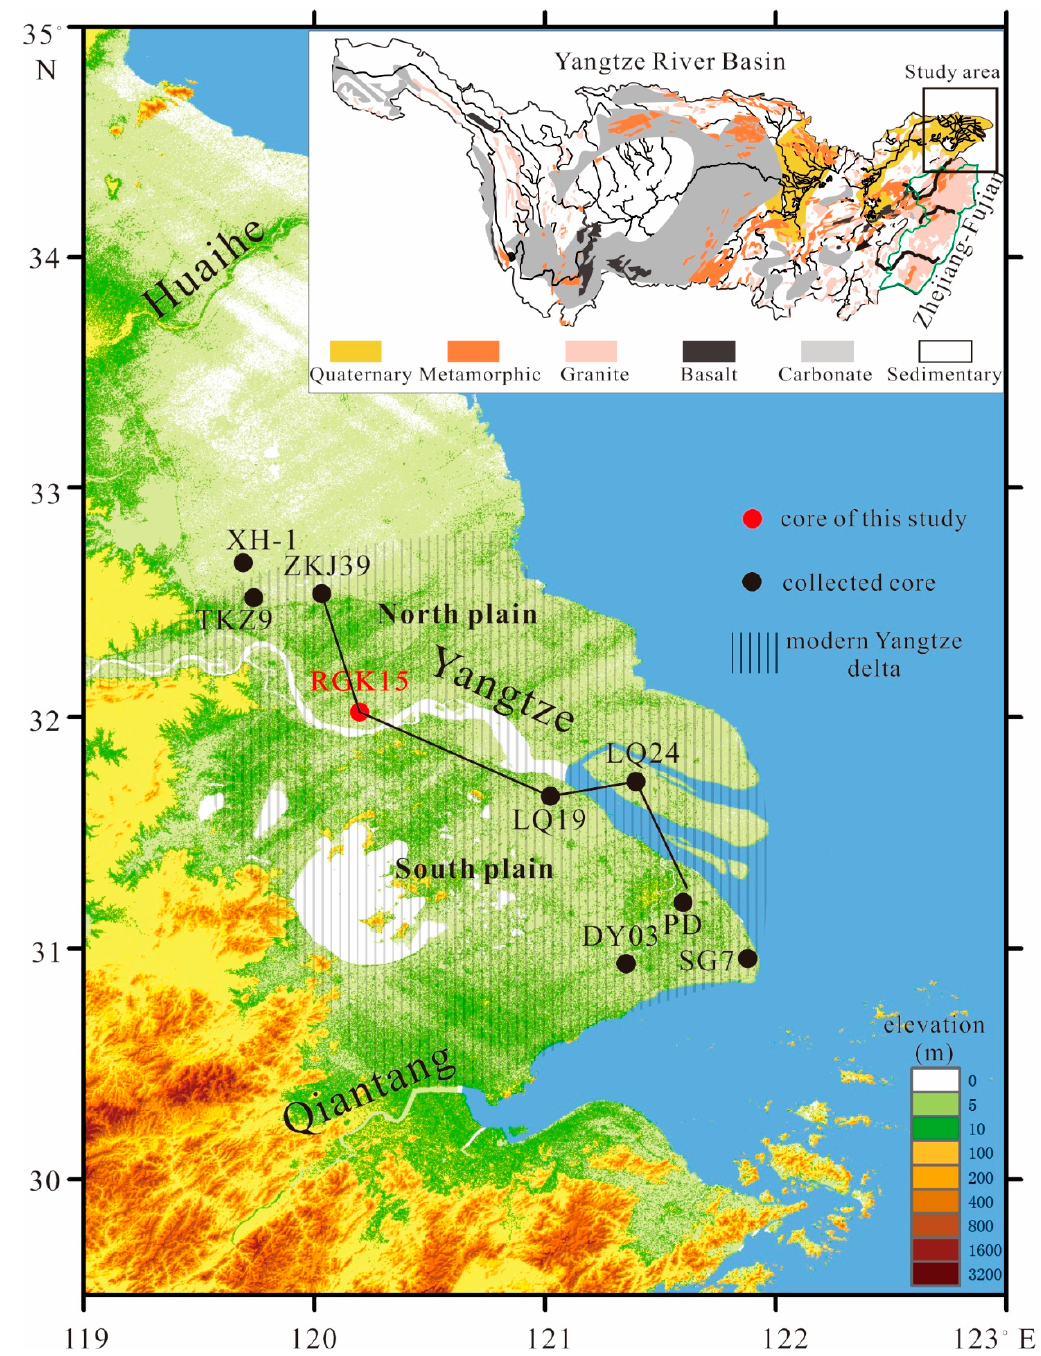
Figure 1. Topographic map and Plio-Pleistocene cores in the Yangtze delta and its surrounding area. The inset in the upper right corner is the geological map of the Yangtze River Basin and the south-eastern coast of China.